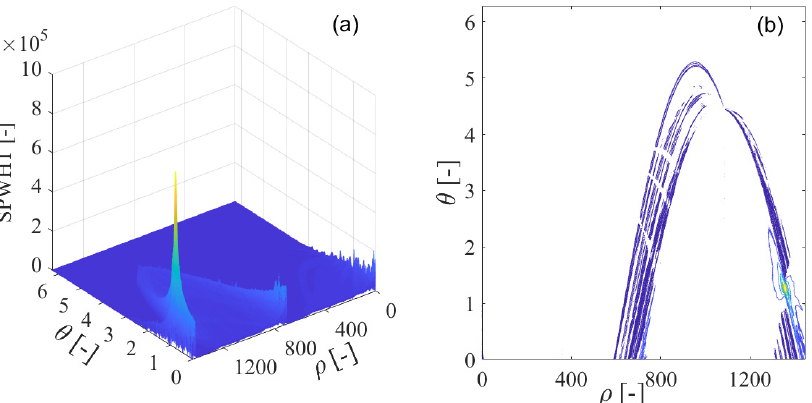
Figure 15. The smoothed pseudo-Wigner–Hough transform (SPWHT) of the GPS L1-C/A signal disturbed by the sweep interference; ( a ) SPWHT; ( b ) SPWHT’s contour.